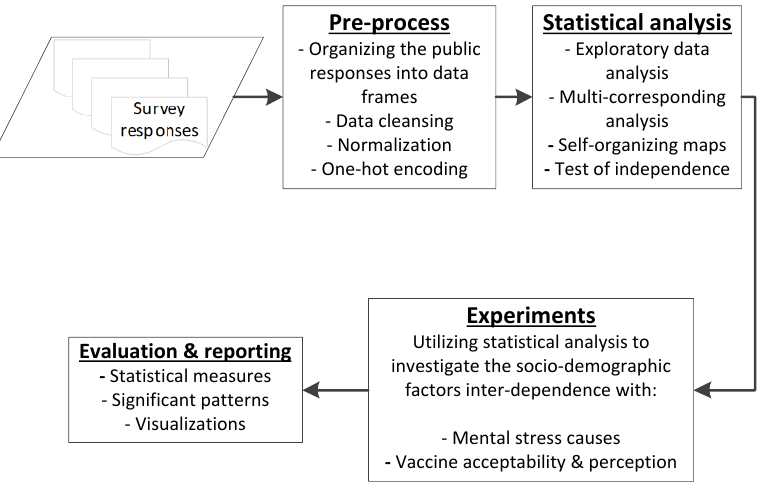
Figure 1. Sequential procedures used in the proposed study to analyse the sociodemographic diversity inter-dependence with mental stress causes and vaccine perception while utilising multiple statistical analysis and pattern-identification tools.